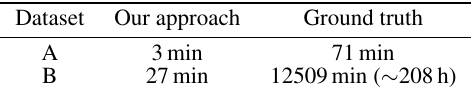
Table 1. The tour length of both our approach and the ground truth generated by brute forcing all valid paths.